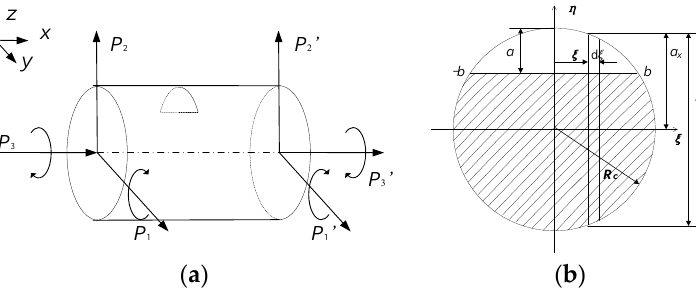
Figure 3. A schematic of the transverse crack, ( a ) is the free body diagram and ( b ) is the section view of the crack.